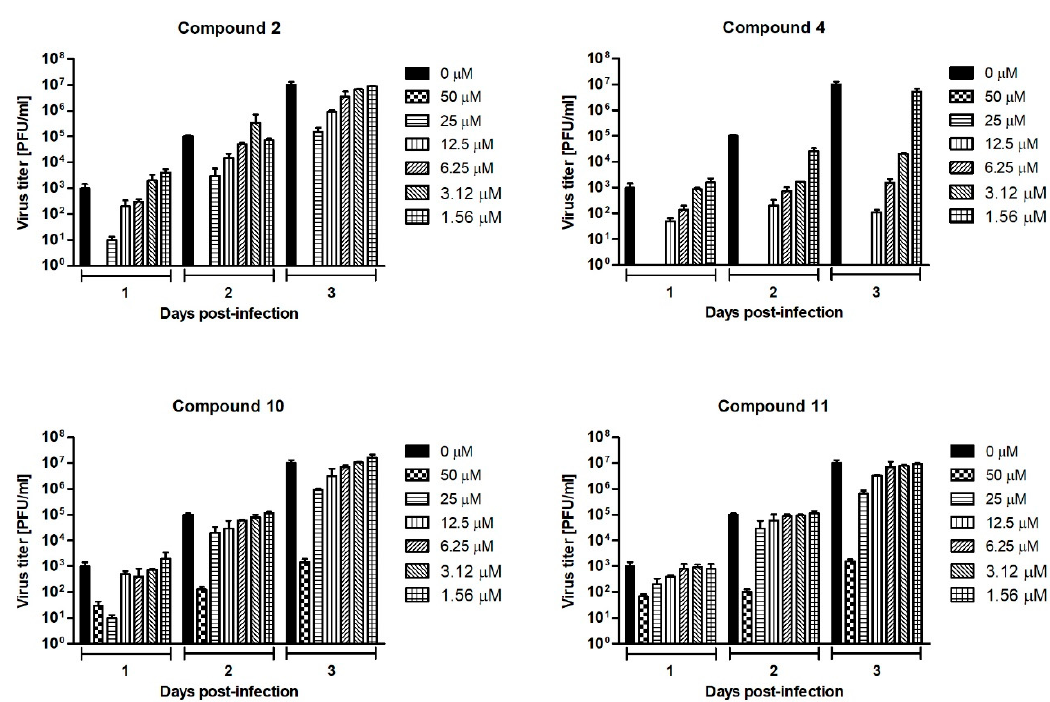
Figure 6. Dose-dependent effect of compounds 2 , 4 , 10 , and 11 on TBEV titers over a 3-day experiment. A549 cells were infected with TBEV Neudoerfl strain at an MOI of 0.1 and treated with different concentrations of compounds. Culture supernatants were collected at days 1, 2, and 3 post-infection and TBEV titers were determined by the plaque assay. Error bars indicate standard deviations from three experiments.